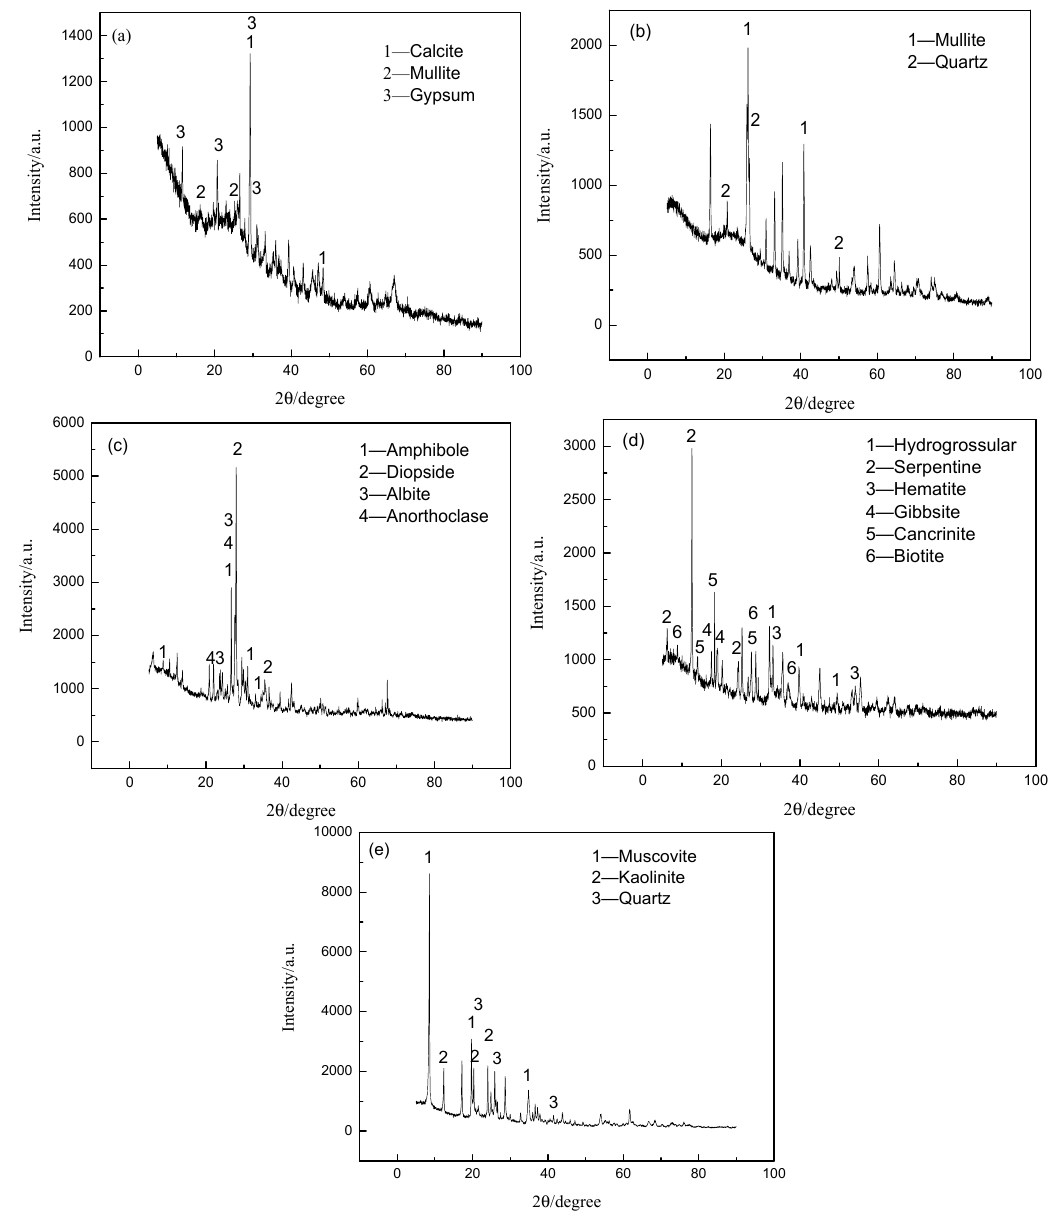
Figure 4. X-ray diffraction patterns of minerals: ( a ) fly ash 1; ( b ) fly ash 2; ( c ) basalt; ( d ) red mud; ( e ) coal gangue.